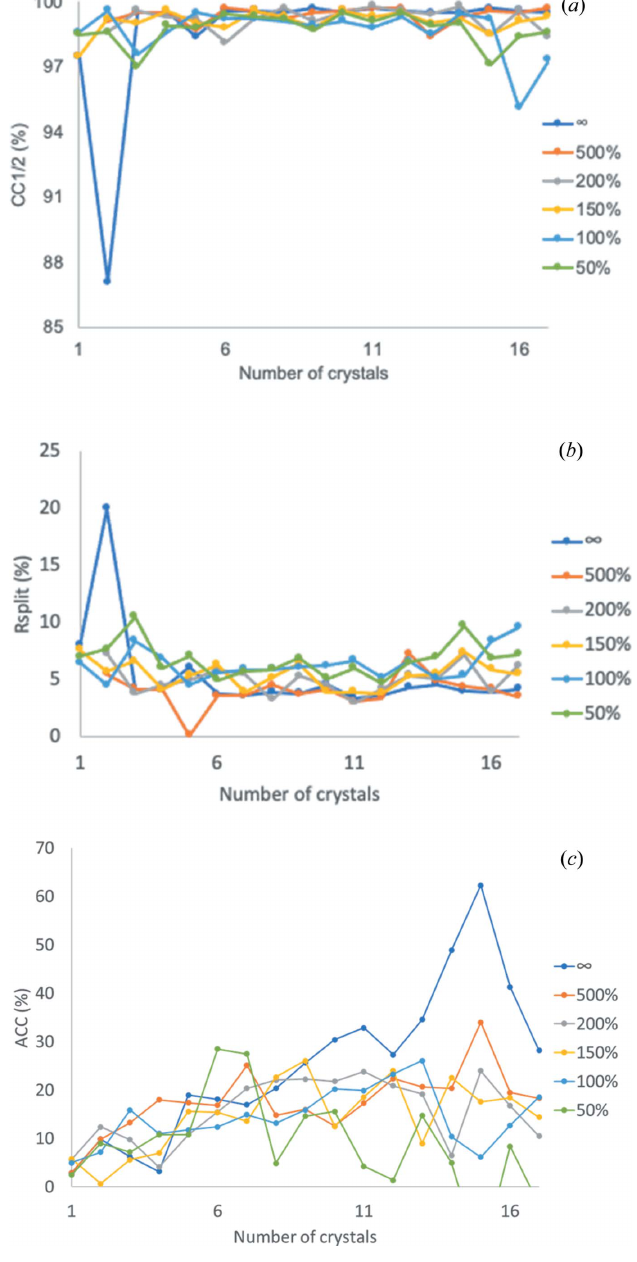
Figure 2 Data analysis of assembled datasets of thaumatin. Frame rejection was performed for each assembled dataset to different extents as described in the Methods : 1 , no frame rejection and 500–50%, where 50% is the most stringent rejection. ( a ) CC 1/2 at 4 A˚ d min . ( b ) R split at 4 A˚ d min . ( c ) Anomalous correlation coefficient (ACC) at 5 A˚ d min . ACC is reported as ‘DelAnom correlation between half-sets’ in the AIMLESS log